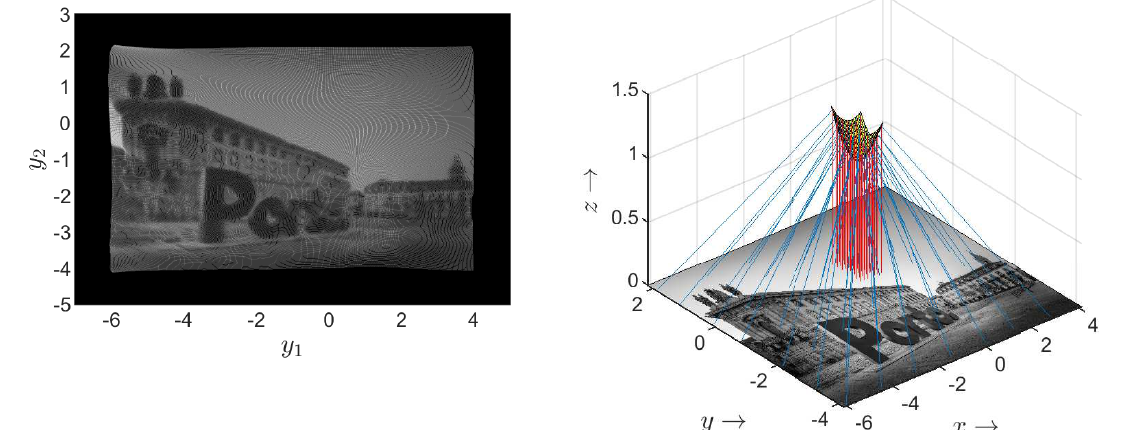
Figure 2: (Left) Ray traced image of Porto projected on a screen in the near field. (Right) Cartoon of a single freeform reflector that converts a small parallel beam (in red) into an output beam (in blue) that produces a picture of Porto on a screen in the near field. Only a small subset of the total rays traced (approximately 100.000) has been